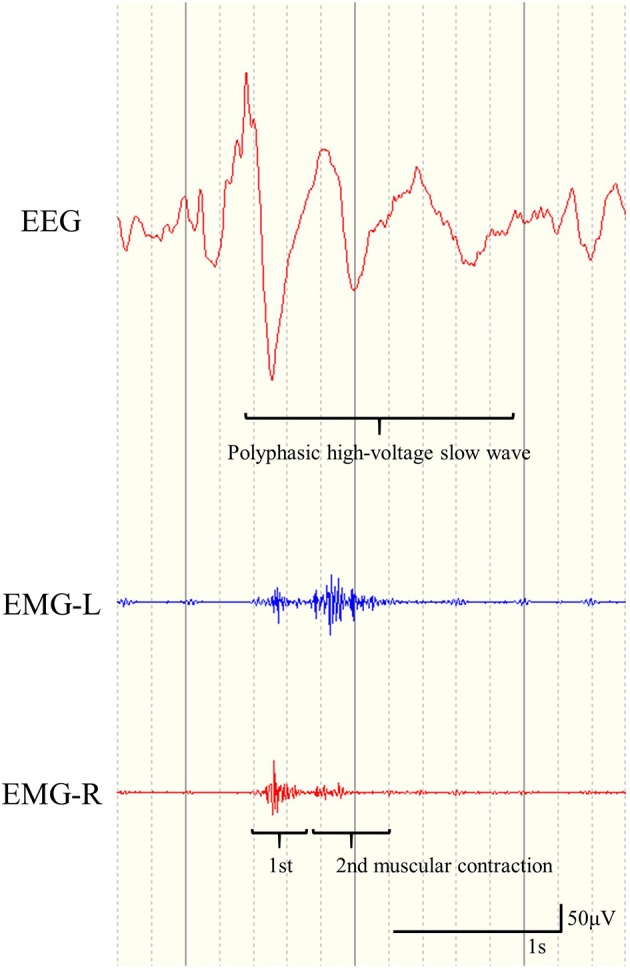
Representative example of electroencephalogram and electromyogram (EMG) findings for epileptic spasms with biphasic muscular contractions. Two sequential rhombus patterns in the EMG recording appear simultaneously with polyphasic high-voltage slow waves.